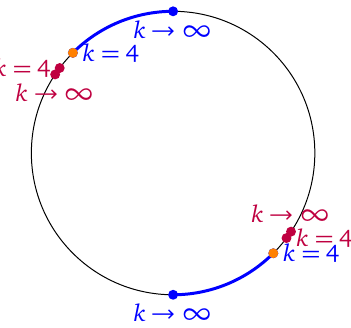
Figure 4: Location of the values of θ in this paper, namely θ orange), as k is varied from k = 4 to k → ∞